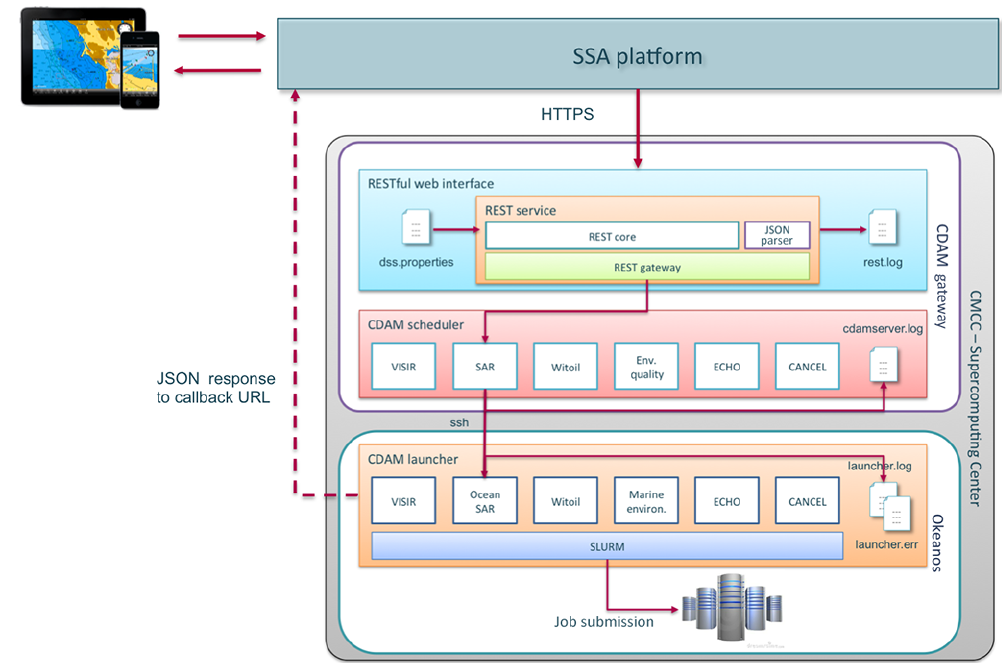
Figure 6. DSS request submission and interactions with the